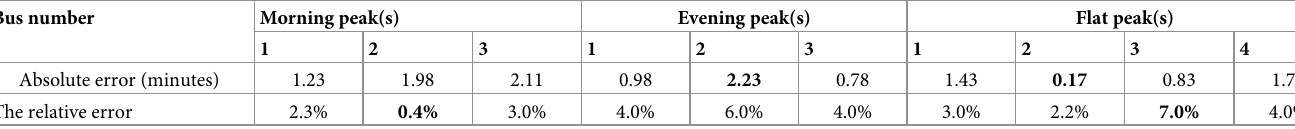
Table 2. Absolute and relative errors of the total travel time prediction of the whole route. Bus